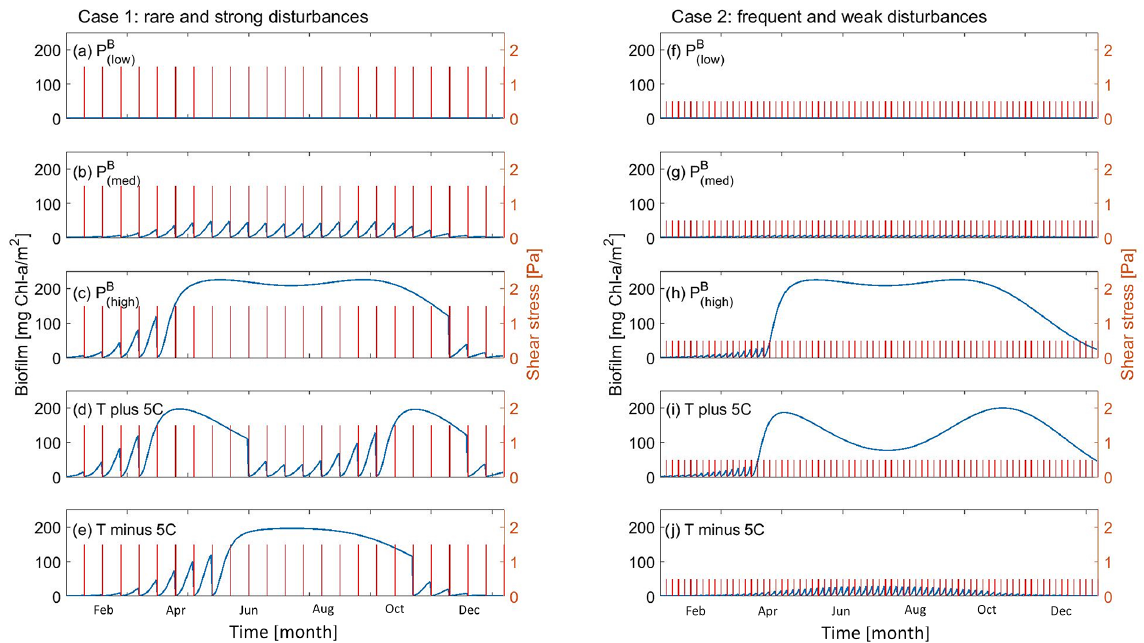
Figure 4. Effect of seasonality and hydrodynamic forces on the evolution of surface biofilm biomass. The evolution of the temperature of the sediment at the bed is simulated for a period of 1 year under rare (every 15d) and strong (1.5Pa) hydrodynamic disturbances. The effect of different values of the growth rate parameter (a, b c) and sediment temperature are investigated (d, e) . The evolution of the temperature of the sediment at the bed is simulated for a period of 1 year under frequent (every 5d) and weak (0.5Pa) hydrodynamic disturbances. The effect of different values of the growth rate parameter (f, g, h) and sediment temperature are investigated (i, j)